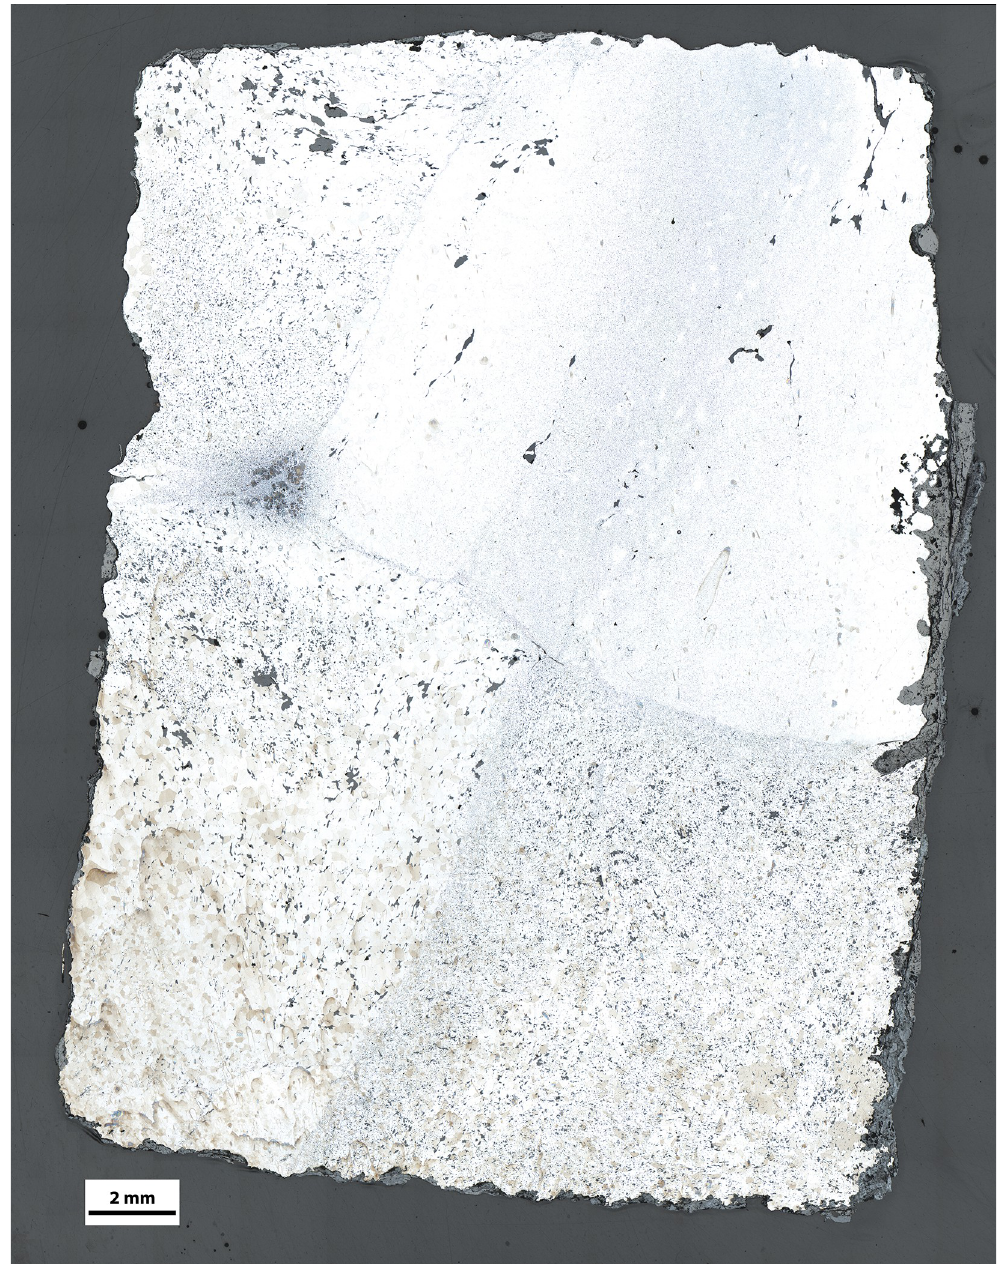
Fig 12. Micrograph of sample VN2-T showing several welding lines and different microstructures (Nital